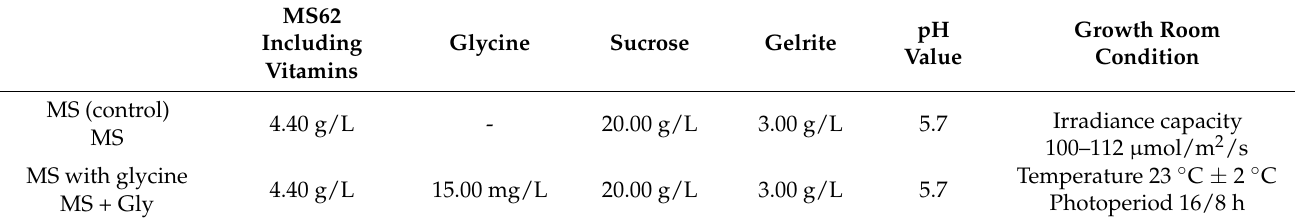
Table 3. Culture media and growth conditions for subculture of PFP.